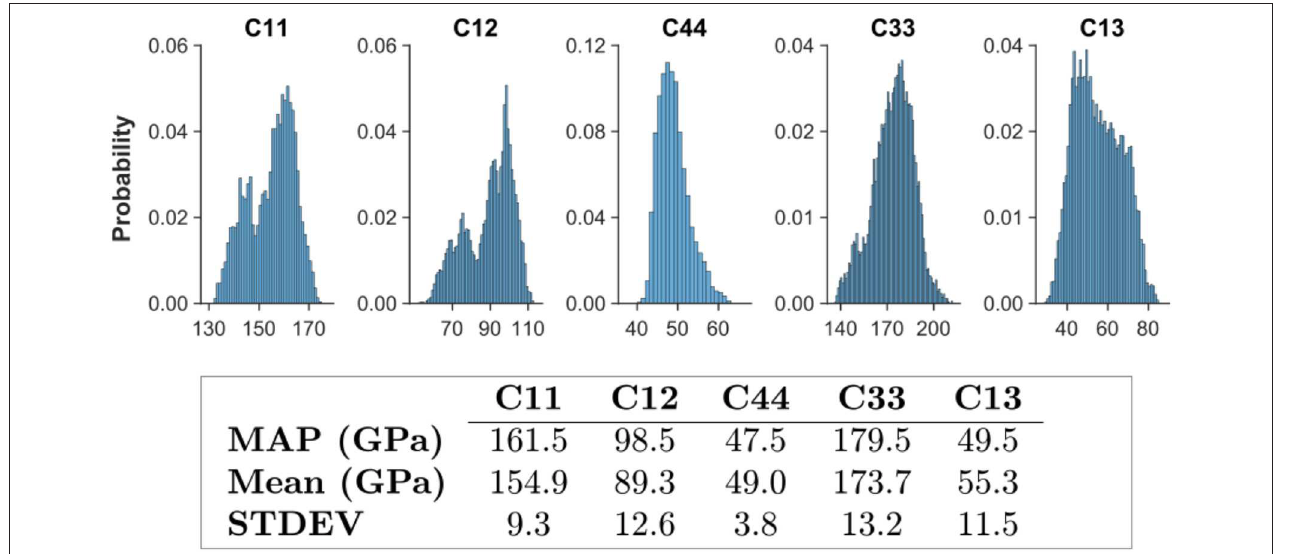
FIGURE 9 | MCMC sampling of the posterior distribution for the intrinsic single crystal elastic constants of CP-Ti.